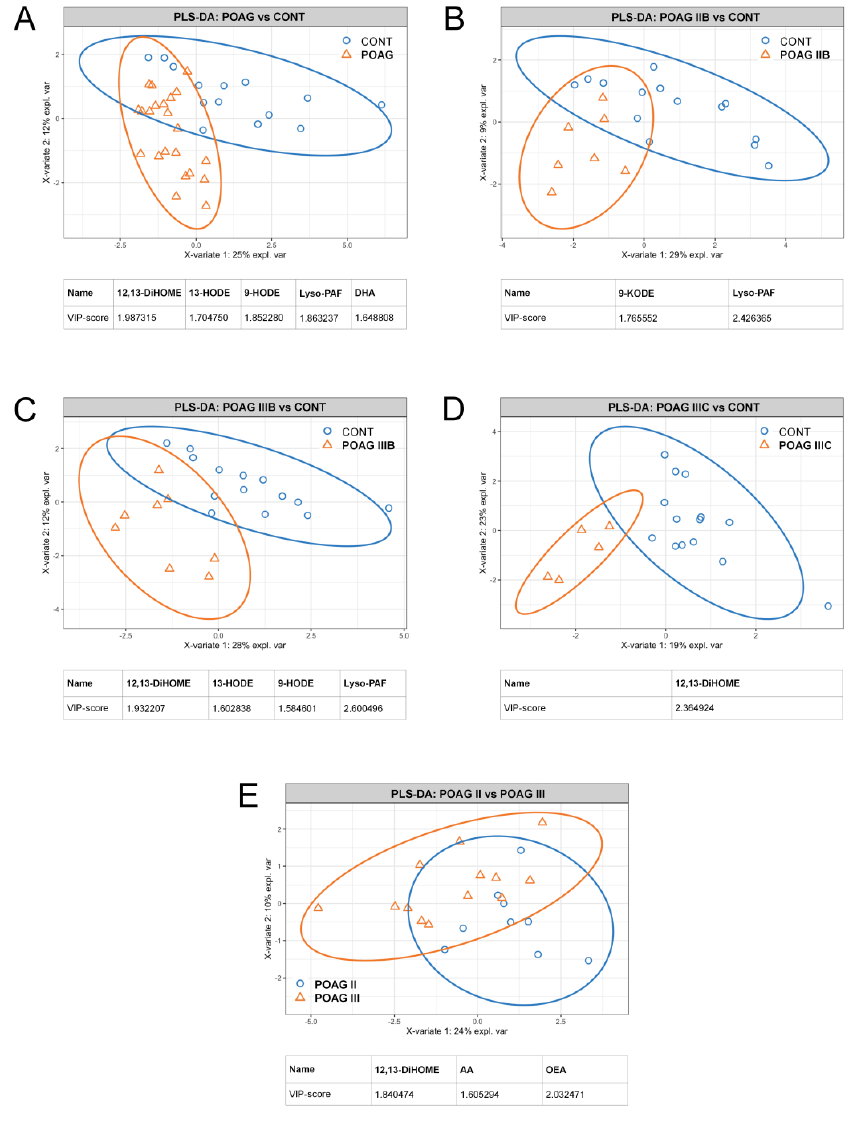
Figure 3. Total and stage/IOP-dependent alterations in the content of signaling lipids in TF of POAG patients. The results of partial least square discriminant analysis (PLS-DA) revealing TF compounds distinguishing total glaucoma patients ( A ) and patients with Stage IIB ( B ), Stage IIIB ( C ) or Stage IIIC ( D ) POAG from the control individuals (CONT). The PLS-DA data regarding comparison of TF contents of signaling lipids patients with different POAG stages regardless IOP levels are also presented ( E ). The explained variance of each component is indicated on the axes. Variable importance in projection (VIP) scores exceeding a cutoff value of 1.5 are considered.